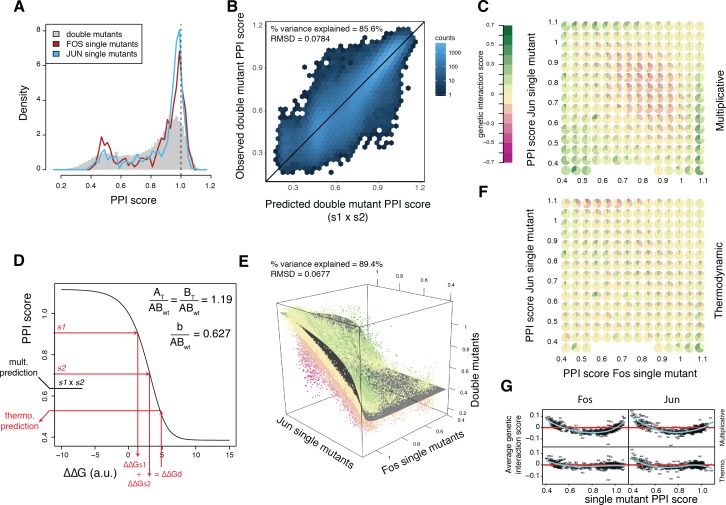
A thermodynamic model predicts double mutant outcomes.(A) Distribution of double mutants PPI scores compared to Fos and Jun single mutants. (B) Observed double mutants PPI scores against the scores predicted by a multiplicative model. (C) Pie chart array of genetic interaction score bins by Fos (x-axis) and Jun (y-axis) single mutant PPI score bins for genetic interactions calculated from the multiplicative model. (D) Fitted thermodynamic model (see Materials and methods). Red arrows illustrate how the sigmoidal function can lead to a different prediction than the multiplicative model. The three fitted free parameters are shown (AT/ABwt and BT/ABwt represent the total concentration of the two proteins relative to the concentration of the wild-type complex and b/ABwt represents the background growth relative to the concentration of the wild-type complex, see Materials and methods). ΔΔGs1, ΔΔGs2 and ΔΔGd represent the change in free energy relative to the wild-type complex of the two single mutants and the double mutant, repsectively. (E) 3D scatter plot of double mutants PPI scores (z-axis) as a function of the corresponding Fos (x-axis) and Jun (y-axis) single mutants PPI scores with the fitted surface from the thermodynamic model. Dot color represents genetic interaction scores according to the color scale in (C). (F) Pie chart array of genetic interaction score bins by Fos (x-axis) and Jun (y-axis) single mutants PPI score bins for genetic interactions calculated from the thermodynamic model. (G) Average genetic interaction score across all double mutants involving a given Fos (left) or Jun (right) single mutant in function of its PPI score for the multiplicative (top) and thermodynamic (bottom) models. Data in all panels is for replicate 1.